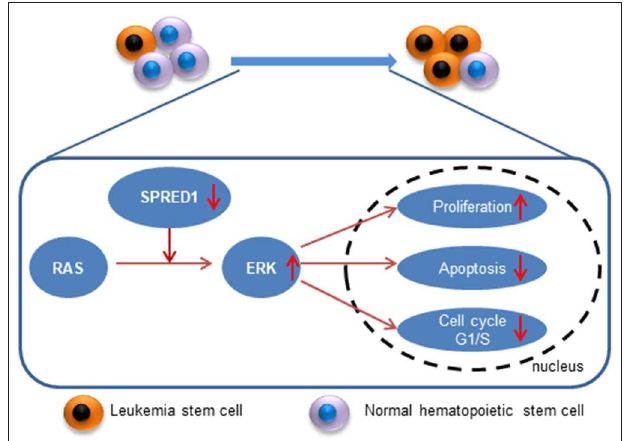
FIGURE 9 | A schematic diagram of the down-regulation of SPRED1 in leukemia transformation.